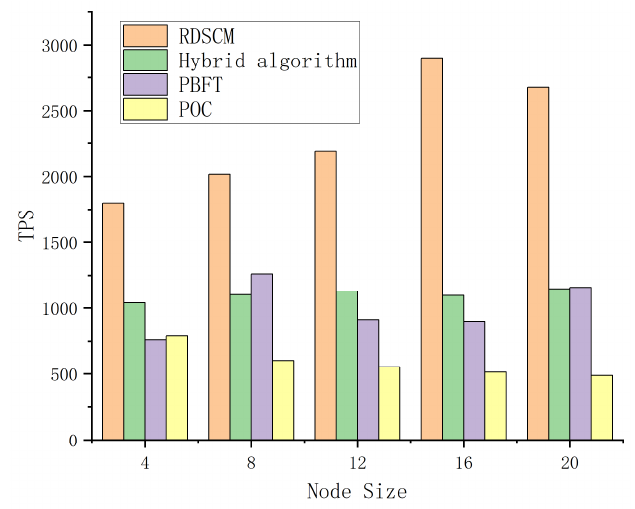
Figure 10. TPS comparison under different numbers of nodes.